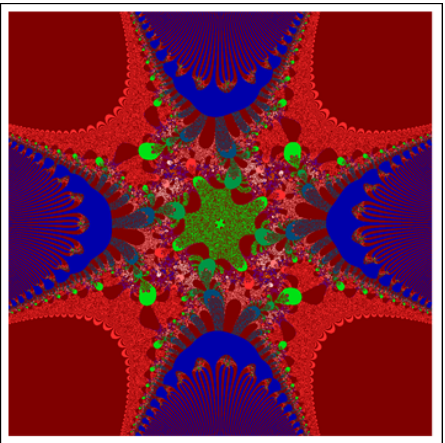
Figure 25. J-set via F-iteration for for e z 4 + ( − 0.5 i ) with image visual time = 1111